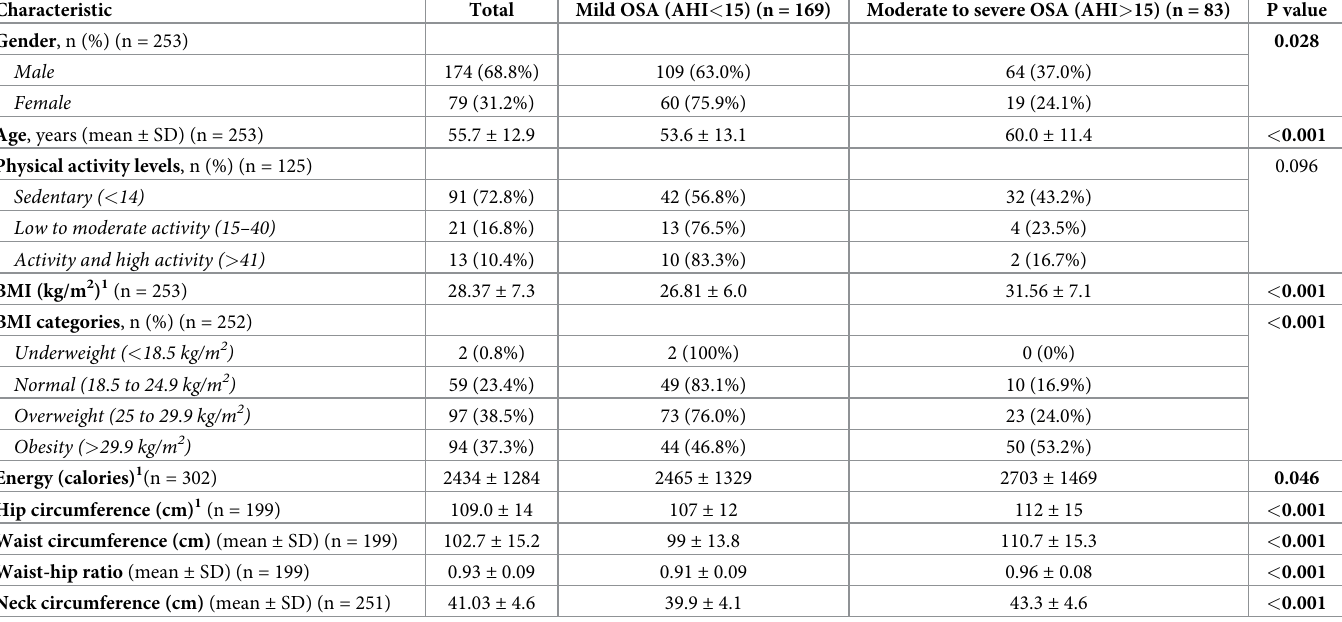
Table 1. Demographic and physical characteristics of the patients according to the categories of apnea hypopnea index representing severity of obstructive sleep apnea (n =